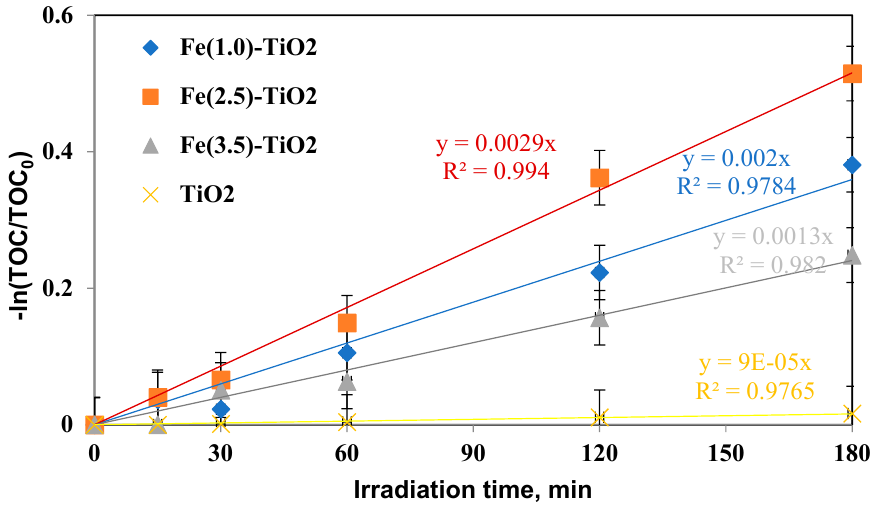
Figure 11. − ln(TOC/TOC 0 ) versus irradiation time (min) for evaluation of mineralization kinetic after 180 min of visible irradiation using undoped TiO 2 (yellow), Fe(1.0)-TiO 2 ( blue), Fe(2.5)-TiO 2 (orange), and Fe(3.5)-TiO 2 (gray) photocatalysts.